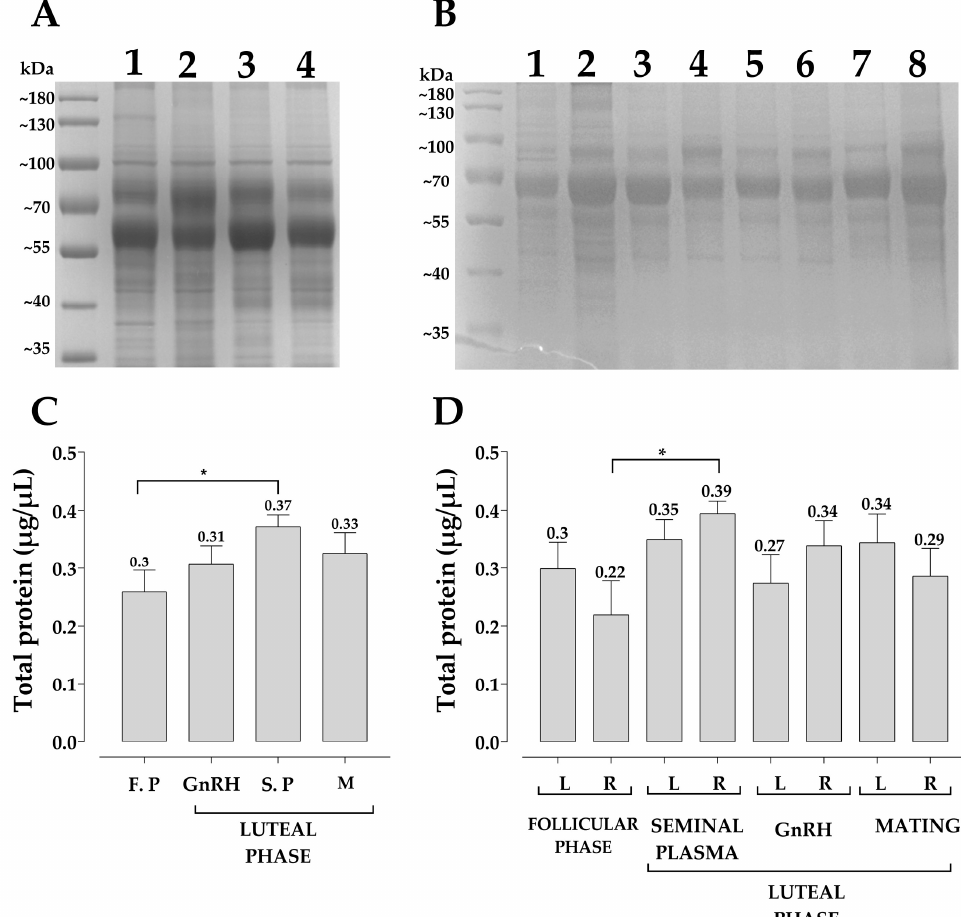
Figure 2. Total protein concentration in fluid uterine is higher in llamas induced with seminal plasma. The quantification of total proteins was carried out by fluorescence measurement. A total of 30 µg of total proteins were separated by electrophoresis on 12% SDS-PAGE gel. Gel staining was completed with 10% Coomassie blue ( A , B ). Lanes 1: follicular phase; 2: GnRH-induced luteal phase; 3: Seminal Plasma-induced luteal phase; 4: Mating-induced luteal ( A ). Lanes 1: left horn of follicular phase; 2: right horn of follicular phase; 3: left horn of luteal phase by seminal plasm; 4: right horn of luteal phase by seminal plasm; 5: left horn of luteal phase by GnRH; 6: right horn of luteal phase by GnRH; 7: left horn of luteal phase by mating; 8: right horn of luteal phase by mating ( B ). Representative bar graph of total protein concentration of uterine fluid, llamas in follicular phase and subjected to ovulation induction with GnRH, seminal plasma and mating ( C , D ). Analysis of uterine fluid of each uterine horn ( C ). Analysis of uterine fluid of each study group ( D ). Each bar represents the mean ± SEM of at least five independent experiments. F. P = follicular phase; S. P = seminal plasma; M = mating; L = left; R = right. * p <